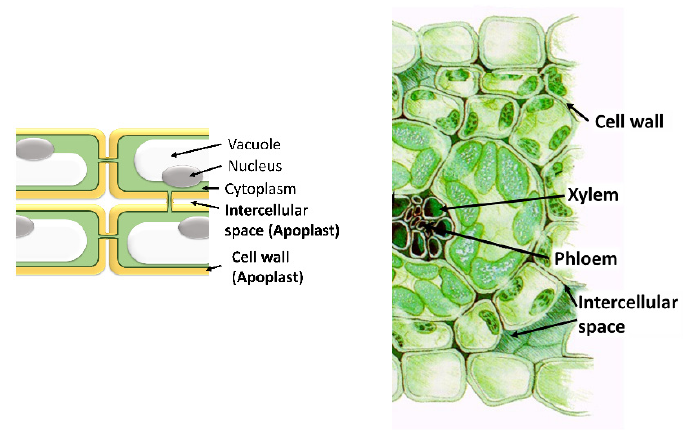
Figure 1. Spaces and structures that form the apoplast in plants. Adapted from: Mluisalozanopulido (CC BY-SA 3.0 (https://creativecommons.org/licenses/by-sa/3.0)).